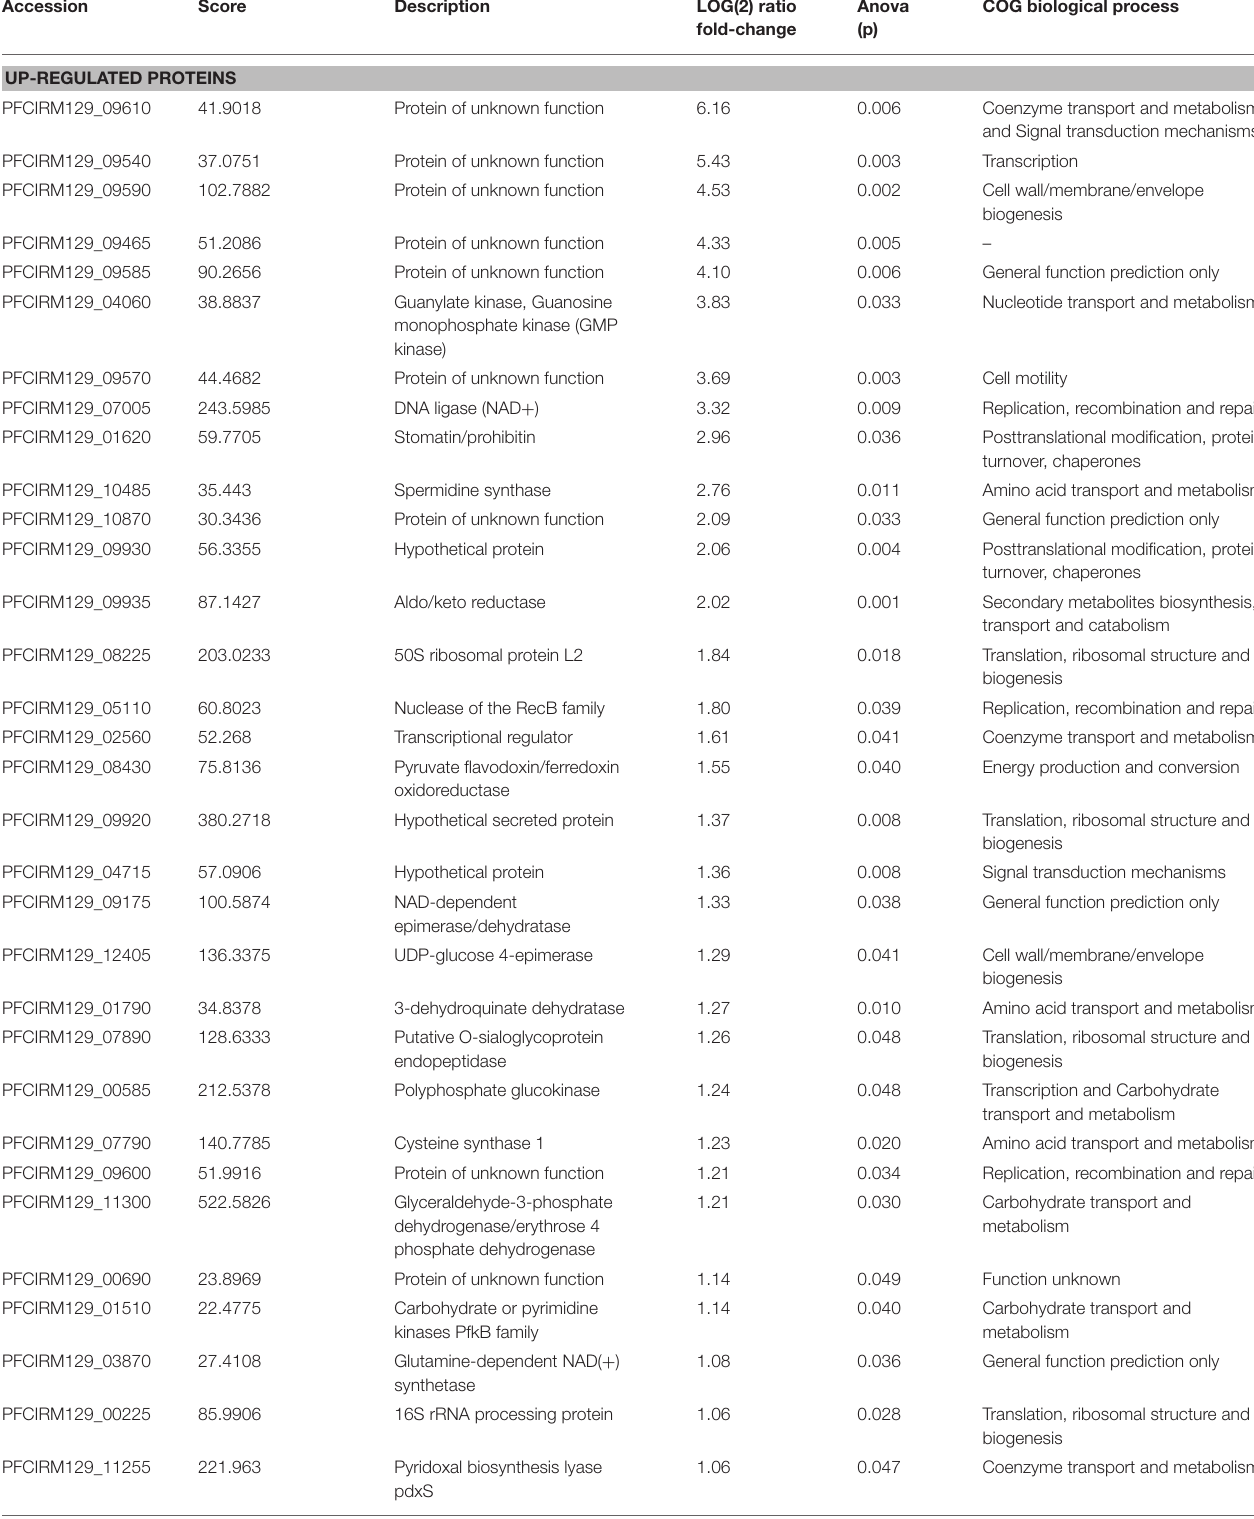
TABLE 2 | Differentially regulated proteins at CB129 1 slpB in relation to CB 129 wild-type.